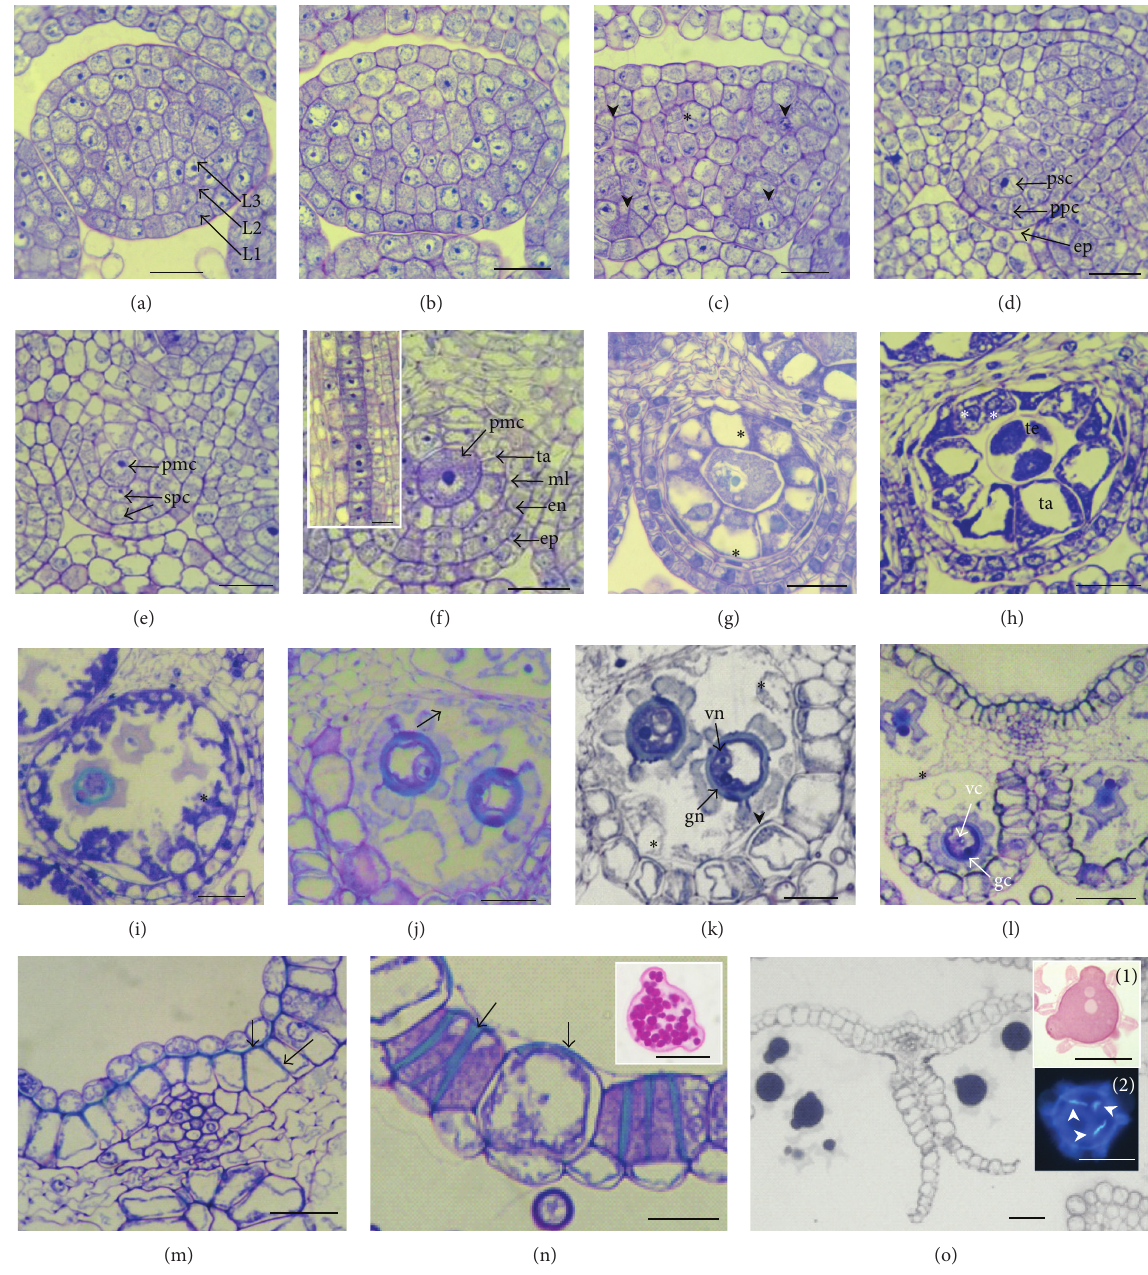
Figure 4: Anther wall and pollen development. (a) Stage 4: round stamen with three germ layers (L1, L2, and L3). (b)-(c) Stage 5: oval shaped anther. The four-locule anther structure established by division of archesporial cells in the four corners (arrow heads). Connectivum differentiation ( ∗ ). (d) Stage 6: under epidermis (ep) the primary sporogenous (psc) and primary parietal cells (ppc) are formed. (e) Stage 7: early pollen mother cell (pmc). Two layers form the secondary parietal cells (spc). (f) Stage 8: late pollen mother cells. Four distinguishable anther layers: epidermis, endothecium (en), middle layer (ml), and tapetum (ta). Inset: row of microsporocytes in a longitudinal section at this stage. (g) Stage 9: meiocytes enter meiosis and tapetum enlarges and becomes vacuolated ( ∗ ). (h) Stage 10: tetrads of microspores (te). In some tapetal cells two nuclei are visible ( ∗ ) (i) Stage 11: release of microspores and tapetal protoplasms intrusion in the locule ( ∗ ). (j) Stage 12: uninucleate vacuolate pollen grain. The septum starts to disintegrate (arrow). (k) Stage 13: binucleate pollen grain (gn: generative nucleus and vn: vegetative nucleus). Endothecium expansion and cell wall thickening (arrow heads). The tapetal cell remains are still visible individually in the locule wall ( ∗ ). (l) Stage 14: bicellular pollen. (gc: generative cell and vc: vegetative cell). The septum is almost fully disrupted ( ∗ ). (m) Magnification of the connectivum region at stage 14 showing U-shaped secondary thickenings (arrows). (n) Magnification of the locule wall showing expanded endothecium cells and their thickened cell walls (arrow heads). Inset: starch grains in the pollen stained by PAS. (o) Stage 15: tricellular pollen. Anther walls have completely opened. Inset 1 shows carbohydrates in the pollen grain stained with PAS and in inset 2 the mature pollen grain with the three nuclei (arrow heads) colored with DAPI. Bars 20 𝜇